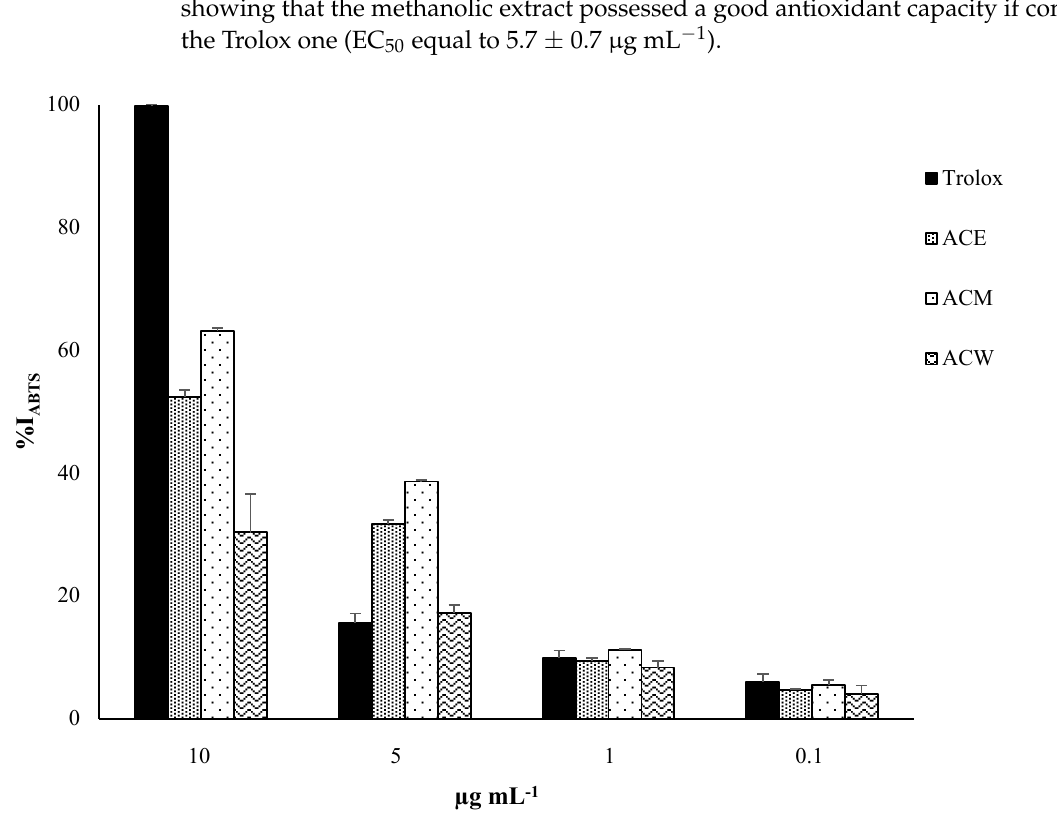
Figure 2. Graphical representation of ABTS inhibition percentage of the extracts from Annona cherimola leaves. Table 2. Radical scavenging activity (ABTS and DPPH) of three extracts from A. cherimola leaves, expressed as µ mol of Trolox equivalents per 100 g of dry